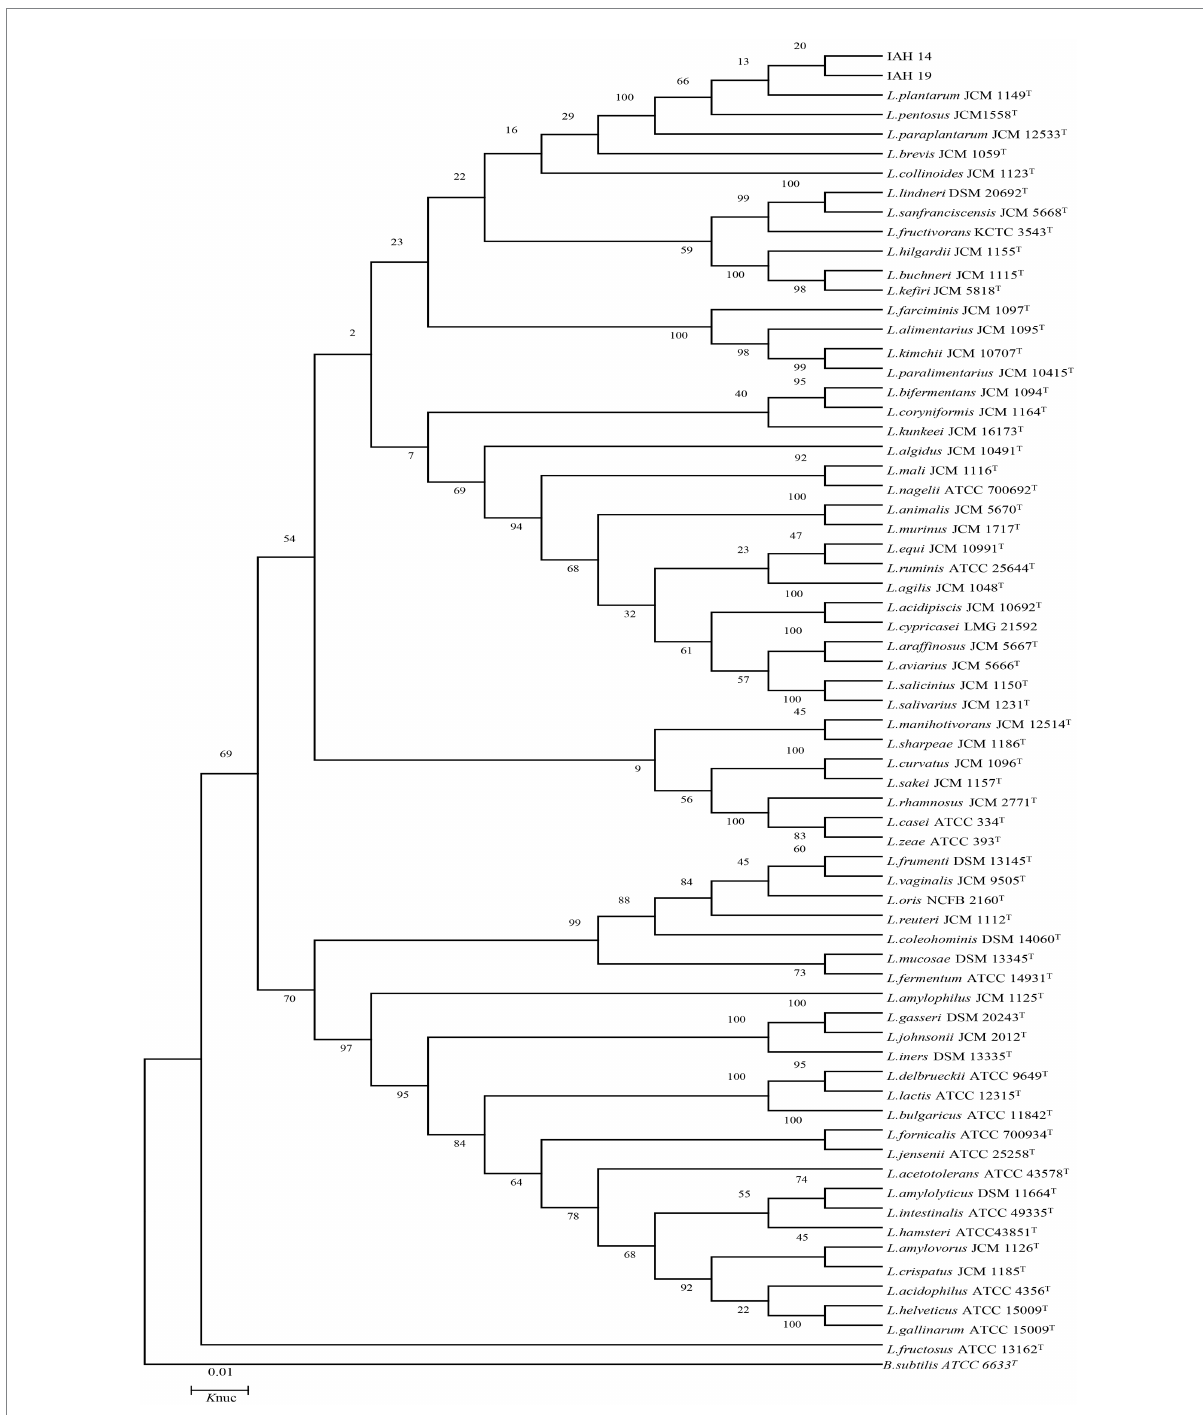
FIGURE 3 Phylogenetic tree showing the relative position of Lactiplantibacillus species and representative strains isolated from natural grasses as inferred by the neighbor-joining method of complete 16S rDNA sequences with 1,000 replicates. Reference sequences of type strains from GenBank are used for comparison, Bacillus subtilis is used as the outgroup. The width is proportional to terminal branch lengths (1% sequence divergence, shown as a scale bar at lower right). L. , Lactiplantibacillus . K nuc, nucleotide substitution